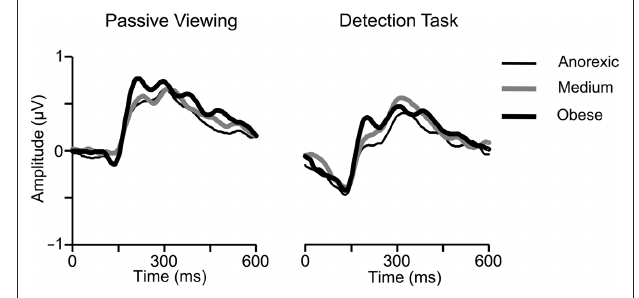
FiguRE 5 | illustration of the ERP waveforms to anorexic, medium, and obese body drawings during passive viewing and active task conditions for a representative right centro-parietal (#183)